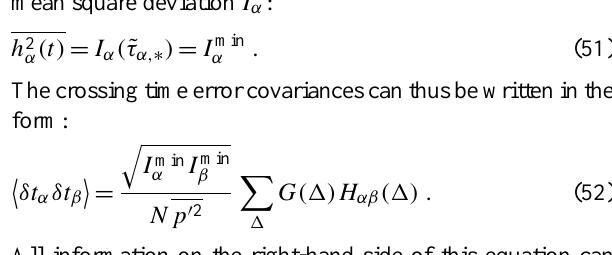
Fig. 4. Crossing time error analysis using a tanh pattern function: Cluster FGM data (solid) and pattern functions (dashed, magenta) used for illustrating the crossing time error formulas. Shown are the B y components of the interplanetary magnetic field measured by the four Cluster spacecraft (S/C 1: black, S/C 2: red, S/C 3: green, S/C 4: blue) when they crossed a directional discontinuity shortly before and after